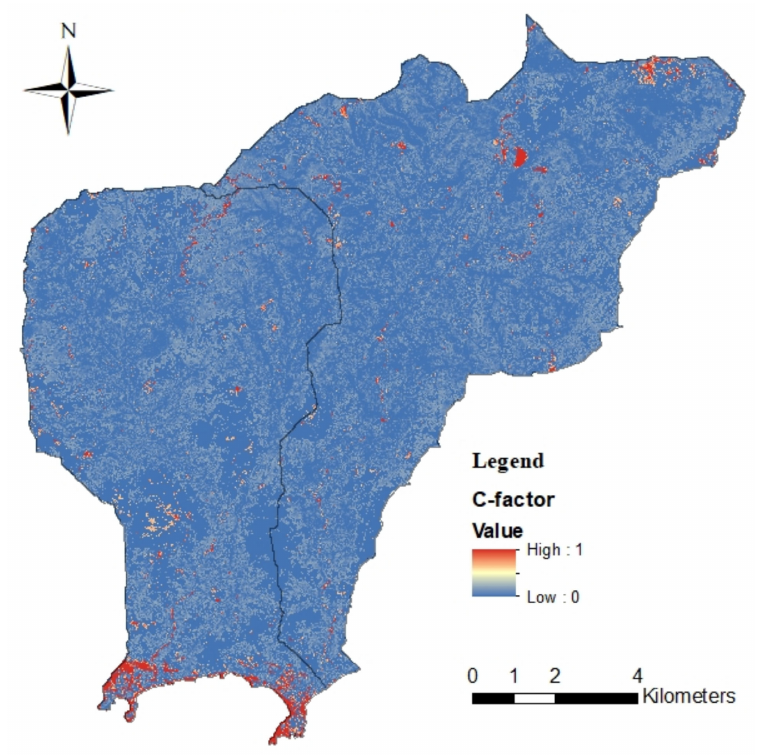
Figure 13. C(FVC)-factor